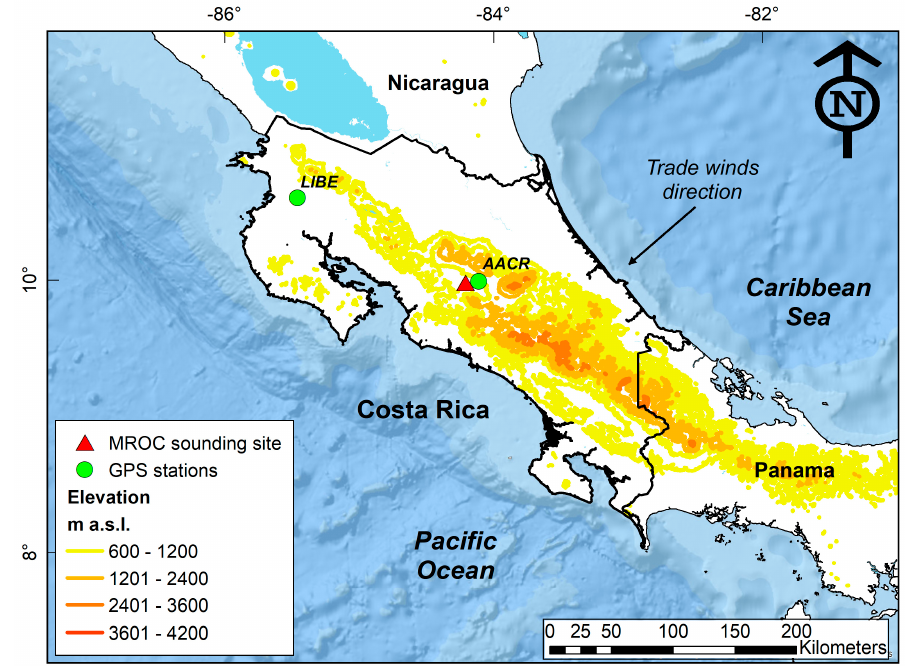
Figure 1. The location of the GPS stations (Liberia, LIBE and Central Valley, AACR, green circles) in Costa Rica and the atmospheric sounding site at the San José International Airport (International Civil Aviation Organization code: MROC, red triangle): The AACR and the MROC sounding site are situated in the central mountainous region of Costa Rica (Central Valley), whereas LIBE is located on the dry corridor of Central America (northern Pacific of Costa Rica).